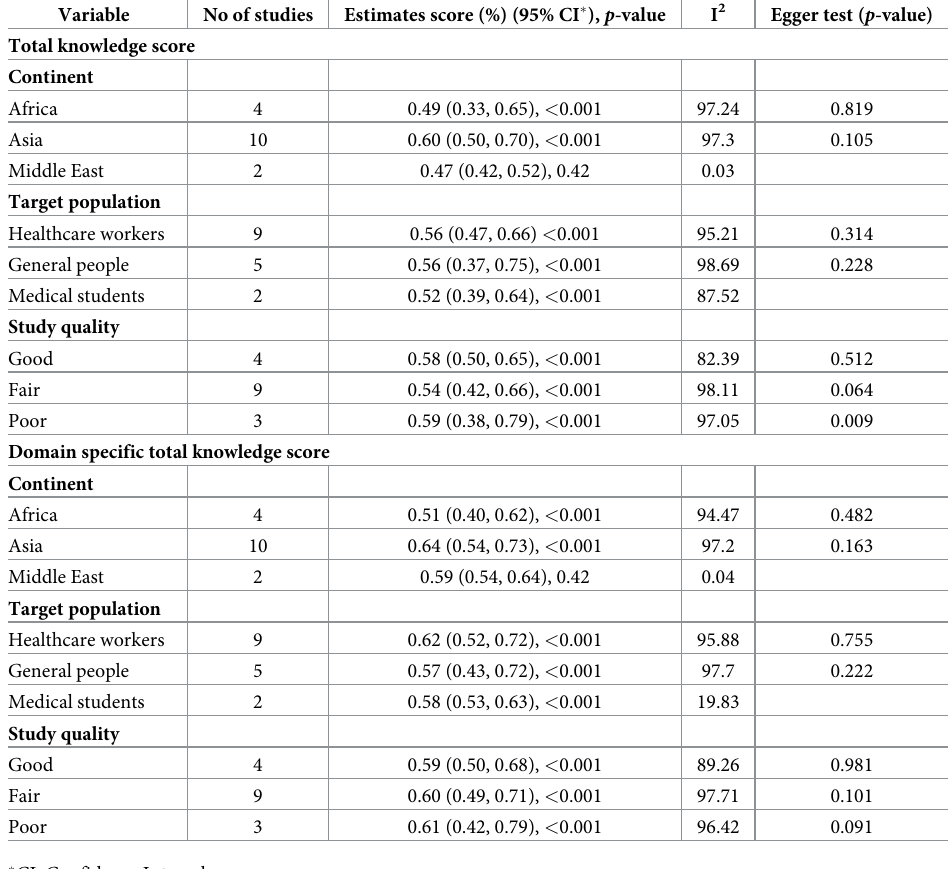
Table 6. Sensitivity analysis for the overall pooled knowledge score and domain specific total knowledge